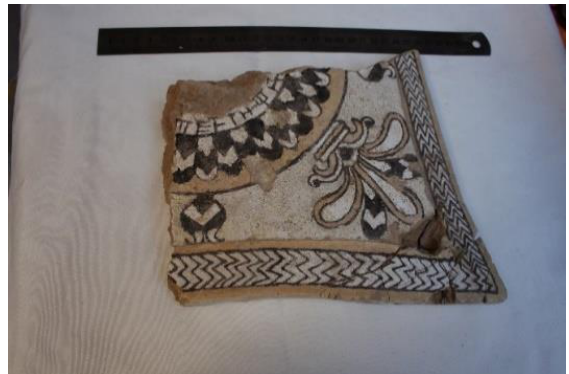
Figure 3. A gazed knobbed tile from Satu Qala 3.2 A Bevelled Rim Bowl from Qala Shila (QSL 18.0.1001)